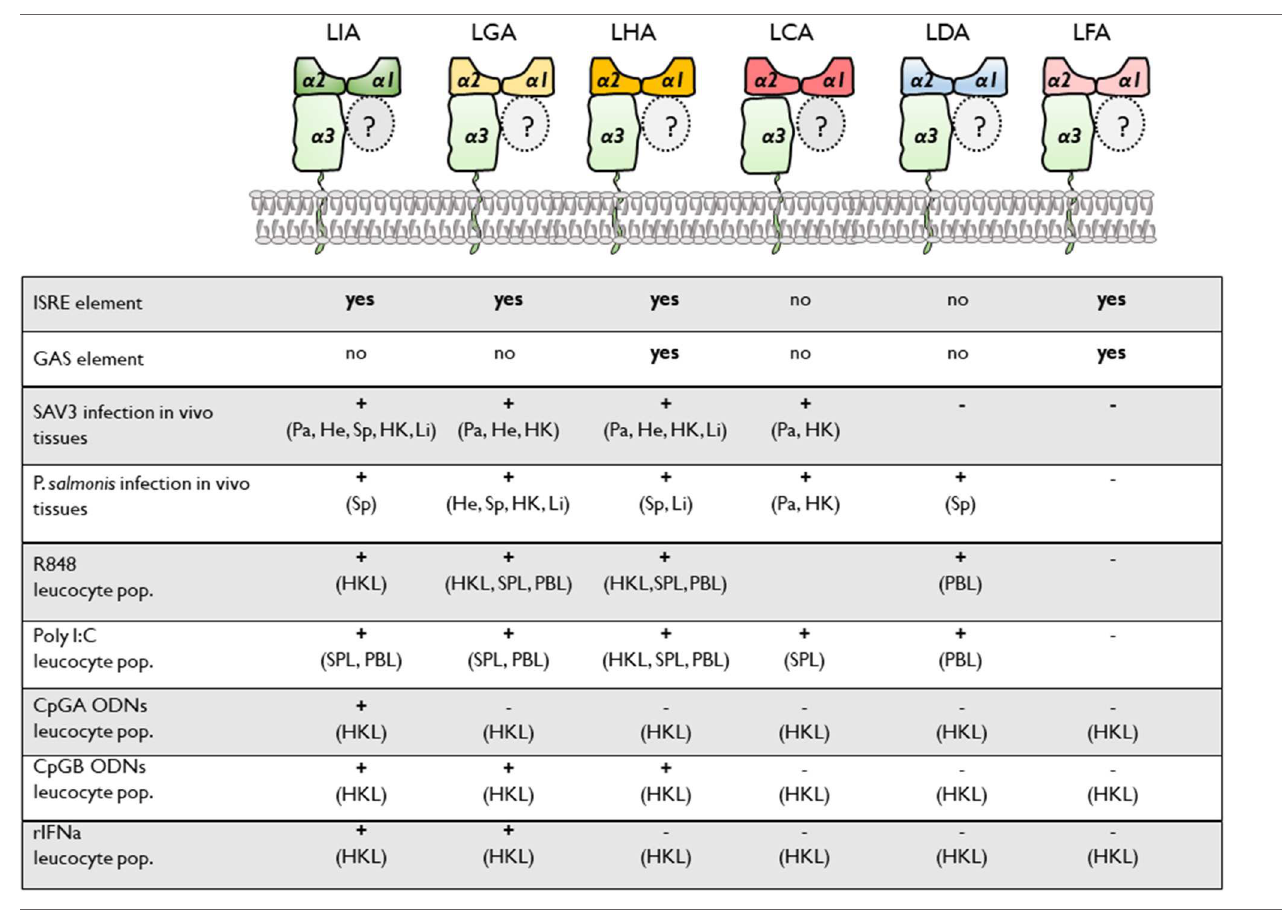
TABLE 1 | Summary of the different proximal promoter response elements and transcriptional induction among Atl. salmon MHC class I L lineage genes.